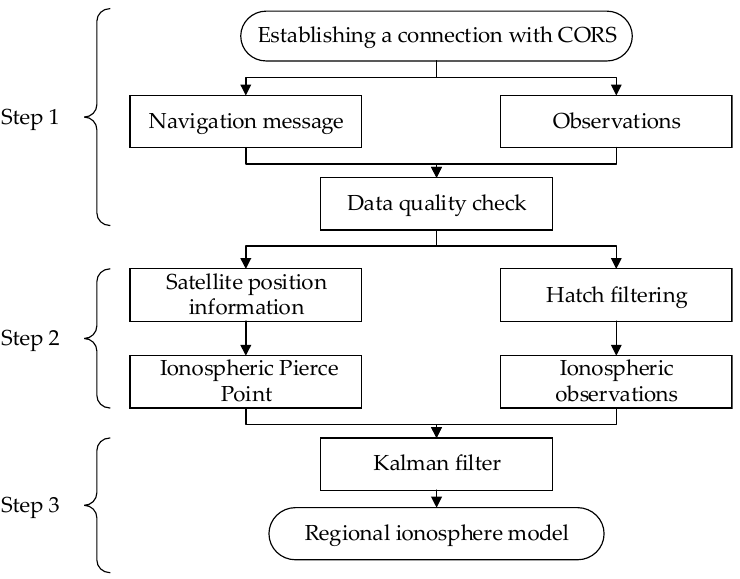
Figure 5. The flow chart of real-time regional ionospheric model. GIM products have good applicability, and the post-processing GIM data can eliminate 80% of the ionospheric delay error. Therefore, this article regards the post-processing GIM file published by CODE as a standard. The Klobuchar model and the regional ionospheric model are used to calculate the ionospheric delay and electron content at the pierce point, and compare them with the standard to calculate the residuals of each satellite, as shown in Figures 6 and